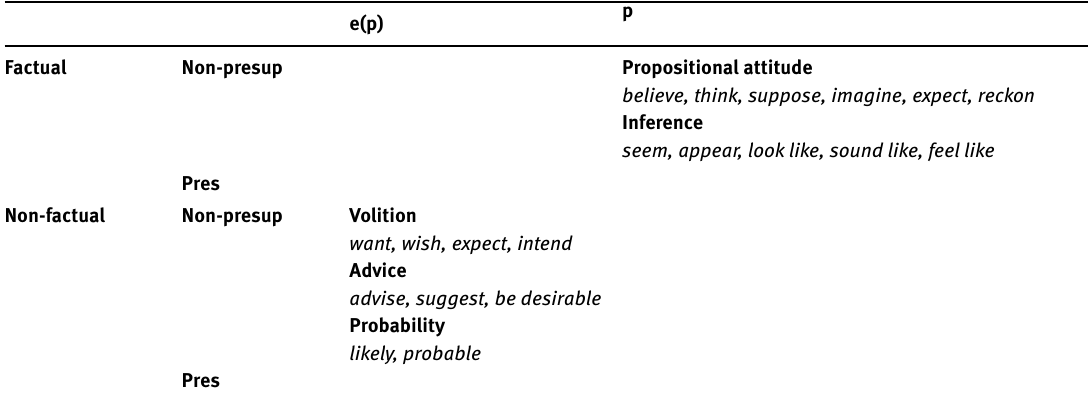
Table 4. Classification of Neg-Raising